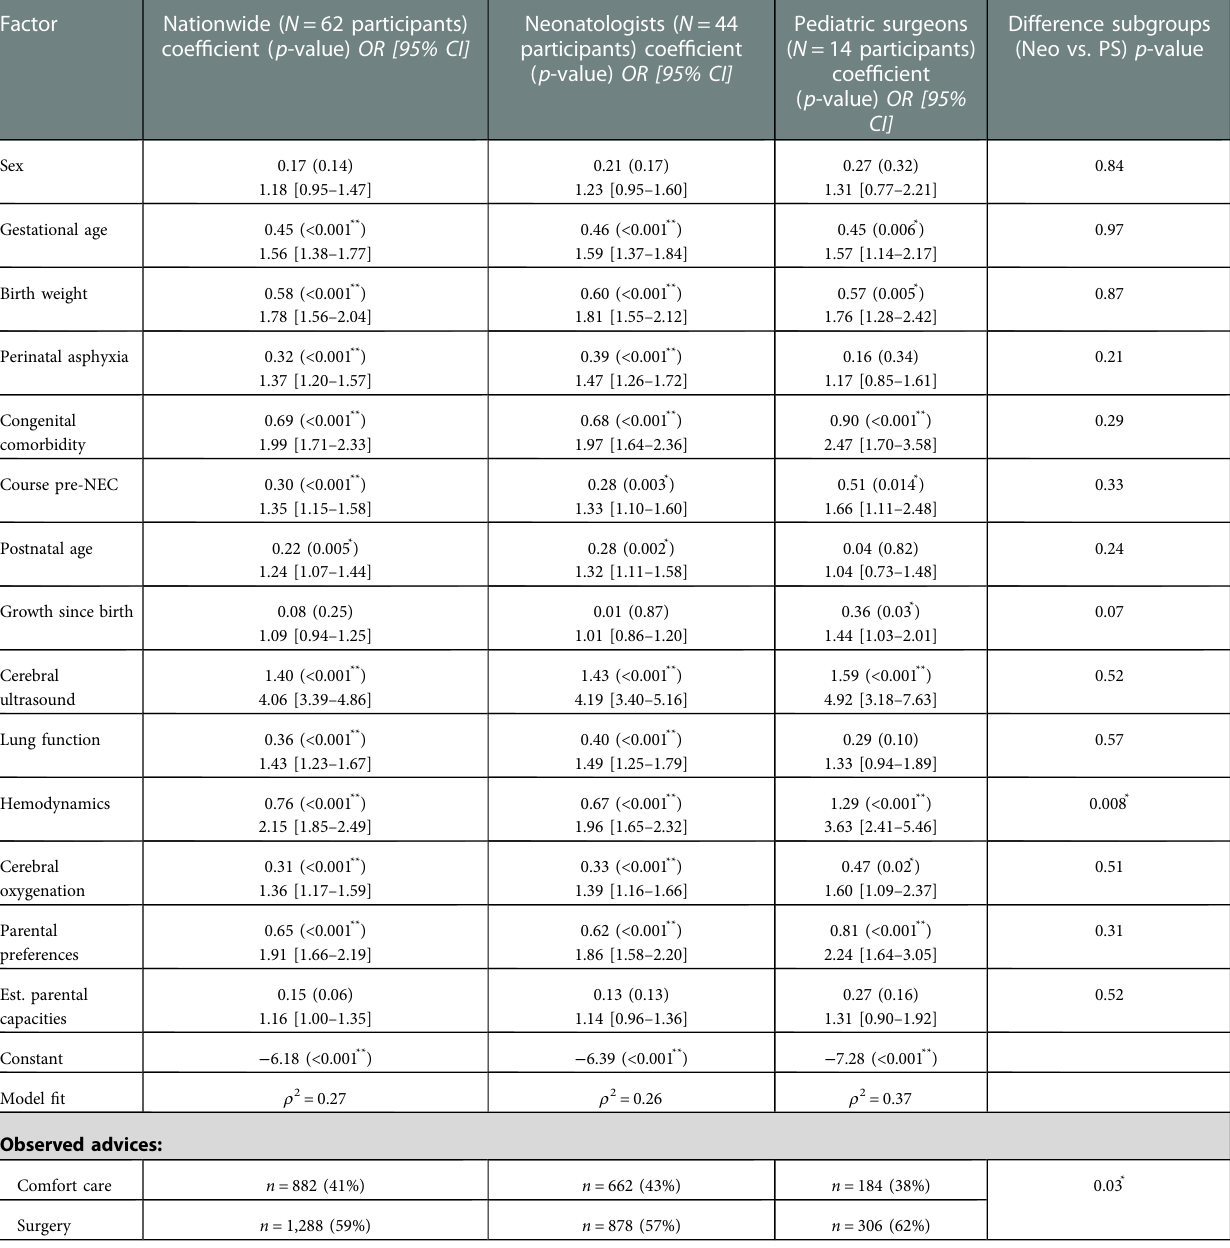
TABLE 3 Estimated linear weight (beta coef fi cient) of each factor per level, of the nationwide analysis and the neonatologist and pediatric surgeon